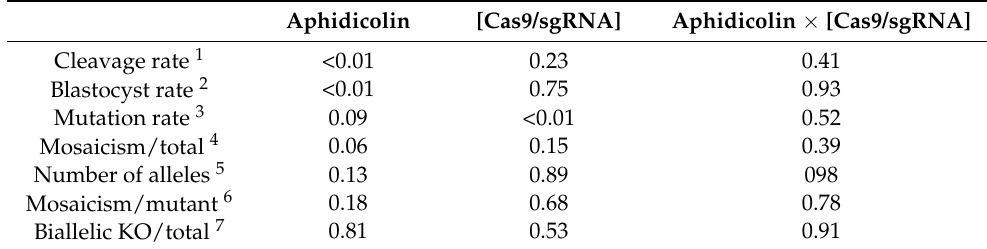
Table 2. Effect of ribonucleoprotein (Cas9/sgRNA) concentration and aphidicolin on mutation pa- rameters expressed as mean ± SEM